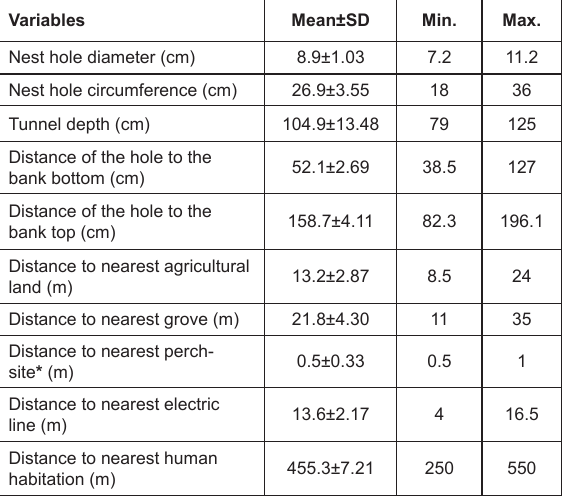
* included small trees, shrubs and